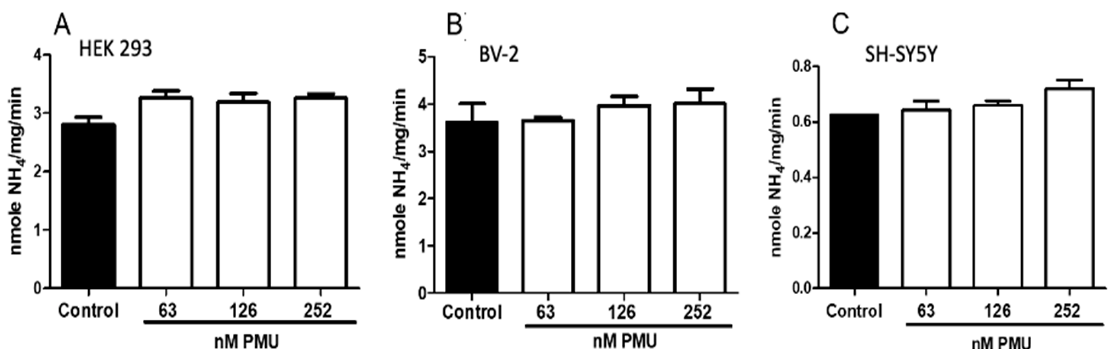
Figure 2. Accumulation of ammonia in the medium of cells cultured in the presence of PMU. Cultured cells ( A ) kidney, HEK293, ( B ) murine microglia, BV-2, and ( C ) human neuroblastoma, SH-SY5Y, were incubated at 37 ◦ C for 24 h with 20 mM sodium phosphate buffer pH 7.0 (NaPB 7.0) (control), or PMU at 63, 126 or 252 nM concentrations. The levels of ammonia accumulated in the cultures’ supernatants were monitored by a colorimetric assay. The results are expressed in nanomoles NH 4 /mg cell protein/min. Results are expressed as mean ± SEM ( n = 9–12 for the control and 9–14 for treatments). The data were analyzed by one-way parametric ANOVA with a Dunnett post-test.